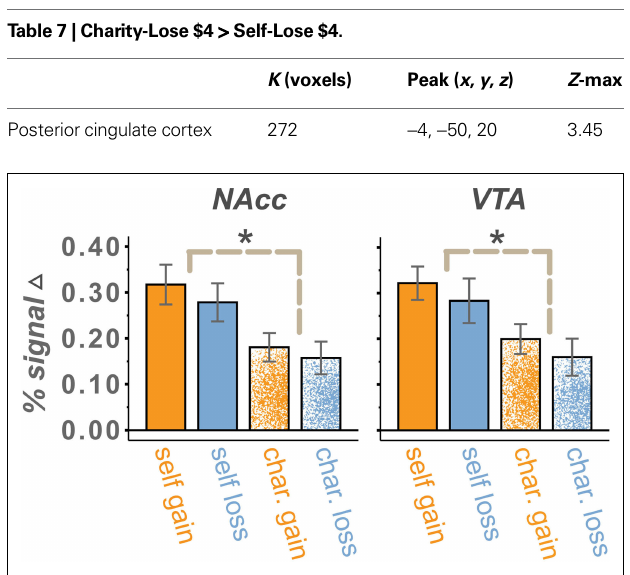
FIGURE 4 | Percent signal change in the NAcc and VTA for $4 vs. $0 trials . Mean activations, relative to $0 conditions, were positive for all trial types. Activations were larger in the Self than Charity treatment condition, refl ecting reliable differences on both gain and loss runs. A trend for a main effect of valence was present in the VTA but not the NAcc. Valence effects that are modulated by the reward sensitivity of the participant were present in both regions. We found no signifi cant differences between $0 conditions. Error bars are ± standard error of the